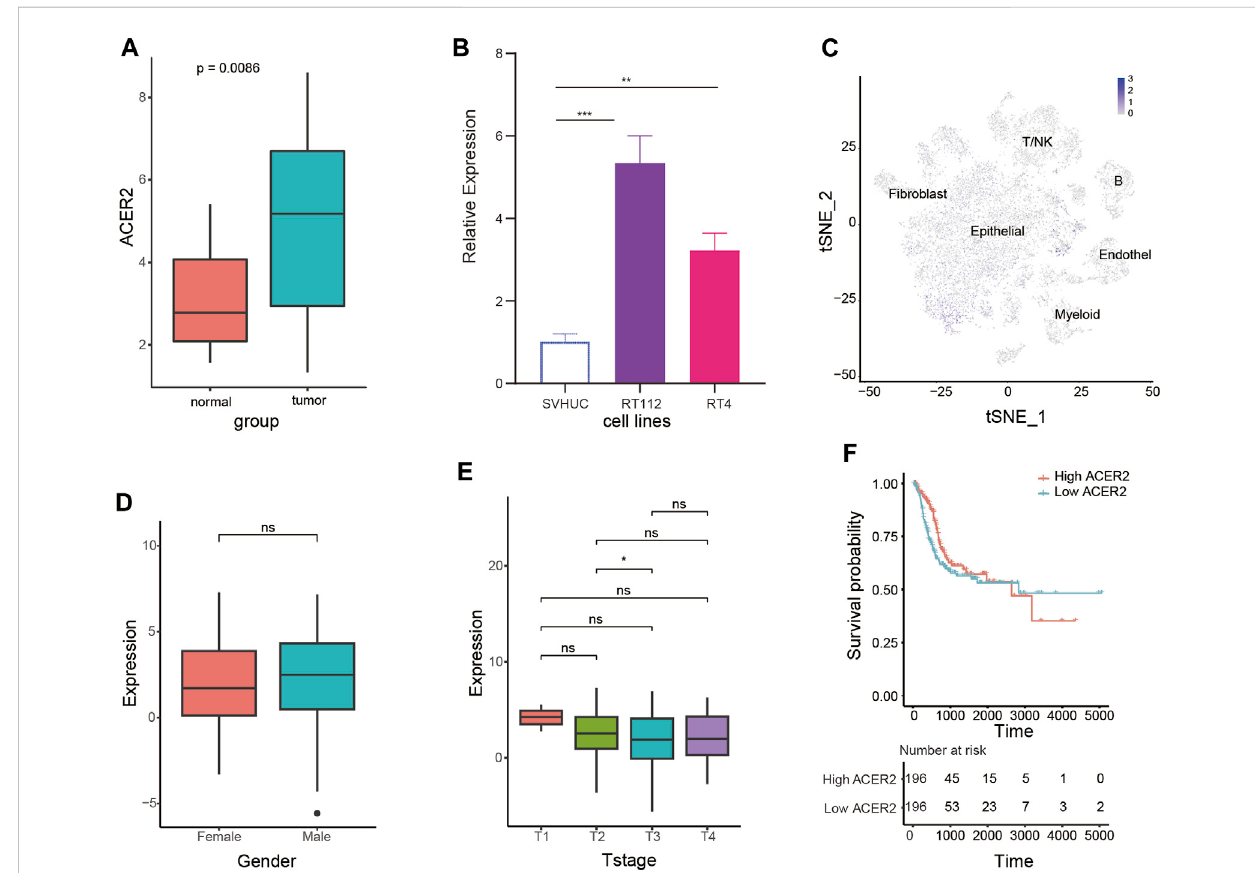
FIGURE 2 ExpressioncharacteristicsofACER2inBLCA. (A) ExpressionanalysisofACER2intheXiangyacohort. (B) ExpressionofACER2indiversecelllines. (C) Single-cell analysis of ACER2 expression in tumor and normal tissues. (D, E) Correlations between ACER2 expression and gender, T stage. (F) Kaplan- Meier curve for disease-speci fi c survival by expression of